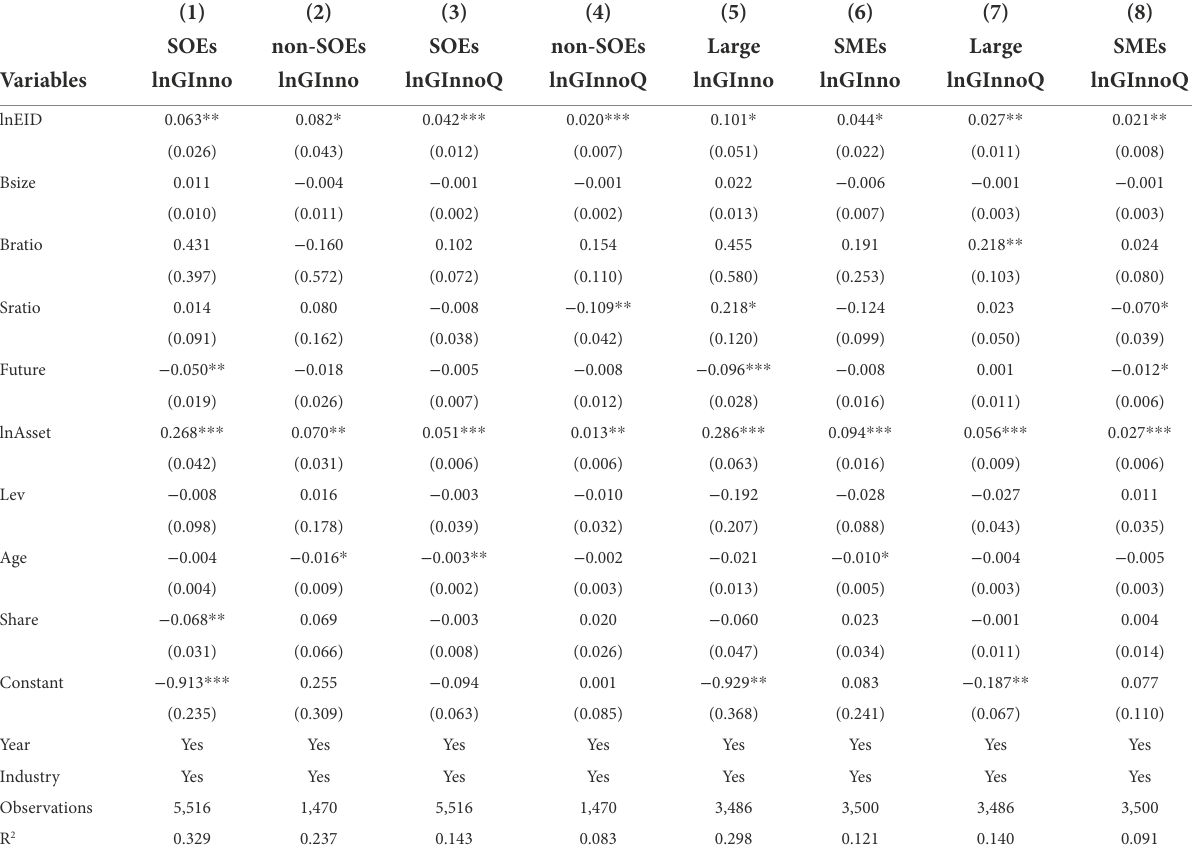
TABLE 6 Heterogeneity of firm ownership structure and firm